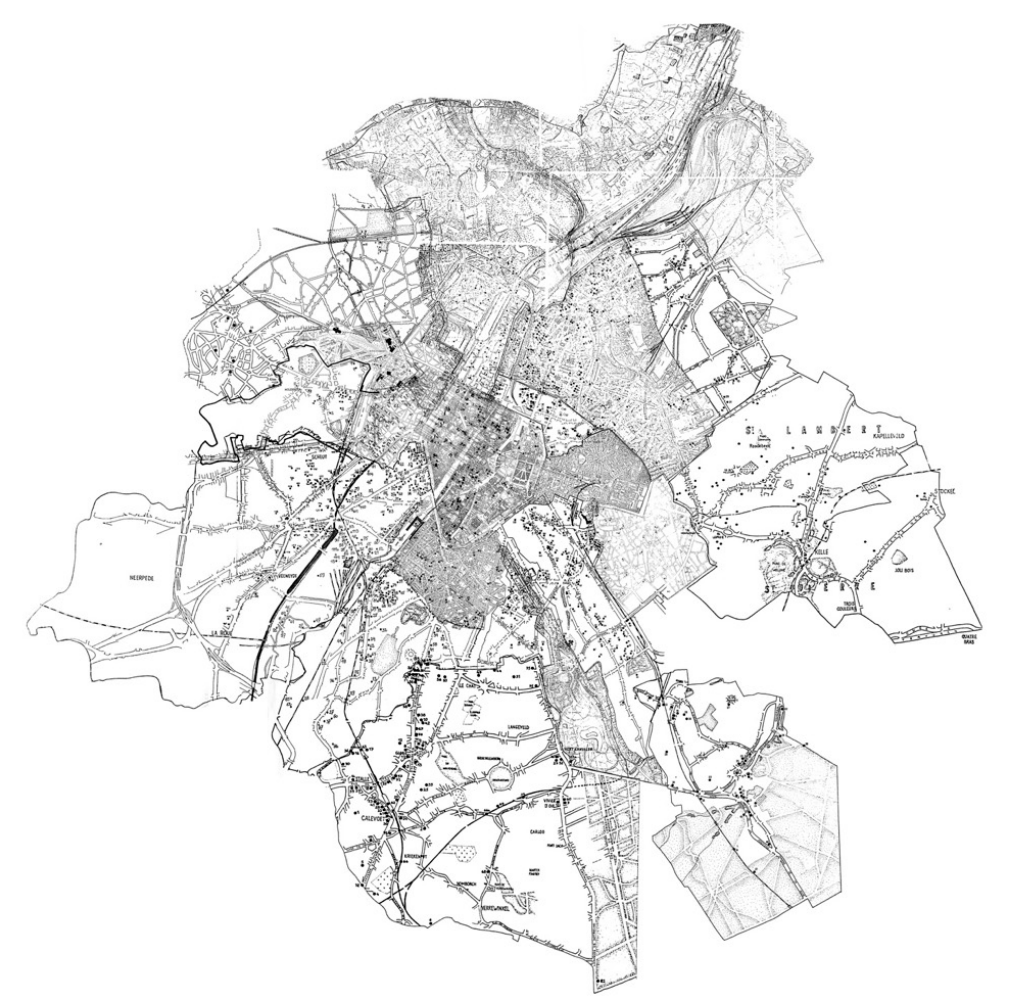
Figure 8. Location and classification of industrial buildings from the Inventaire Visuel (Culot & the AMM,